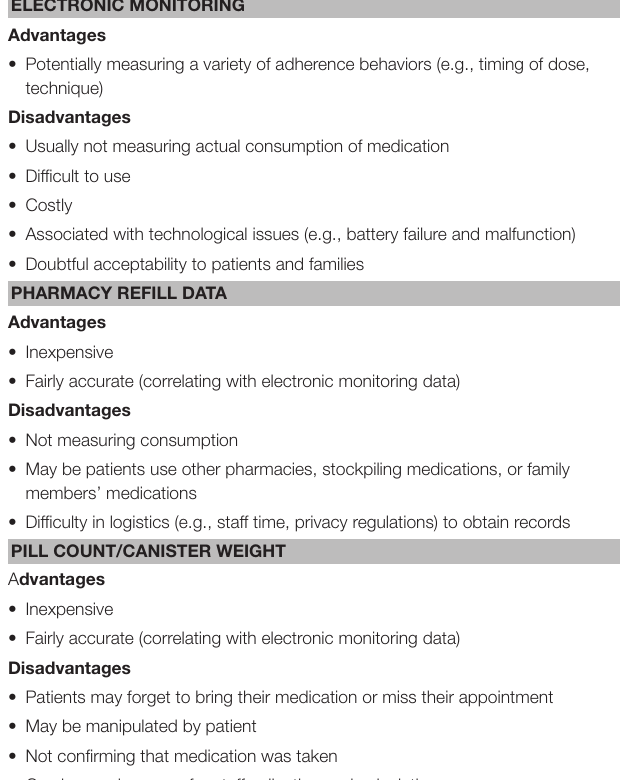
TABLE 2 | Summary of objective and subjective methods for adherence assessment (34). Objective